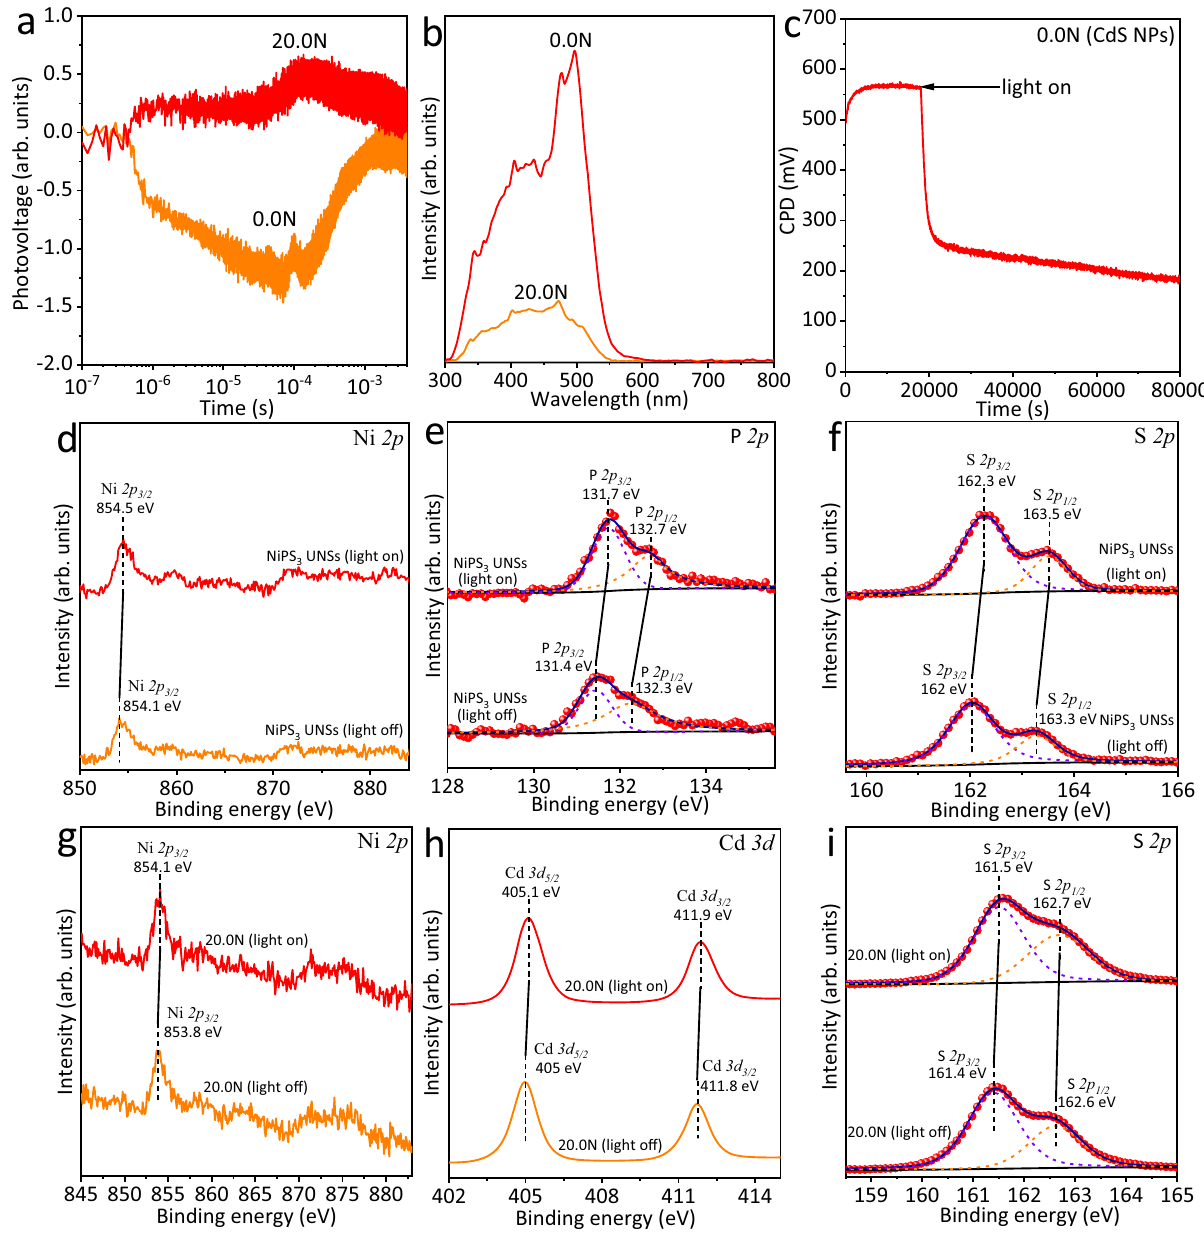
Fig. 5 | Charge carrier kinetics in NiPS 3 /CdS system. a Transient-state and b steady-state SPV spectra of 0.0N and 20.0N. c CPD test of 0.0N in the dark and under light irradiation. High-resolution XPS spectra of d Ni 2p , e P 2p and f S 2p of